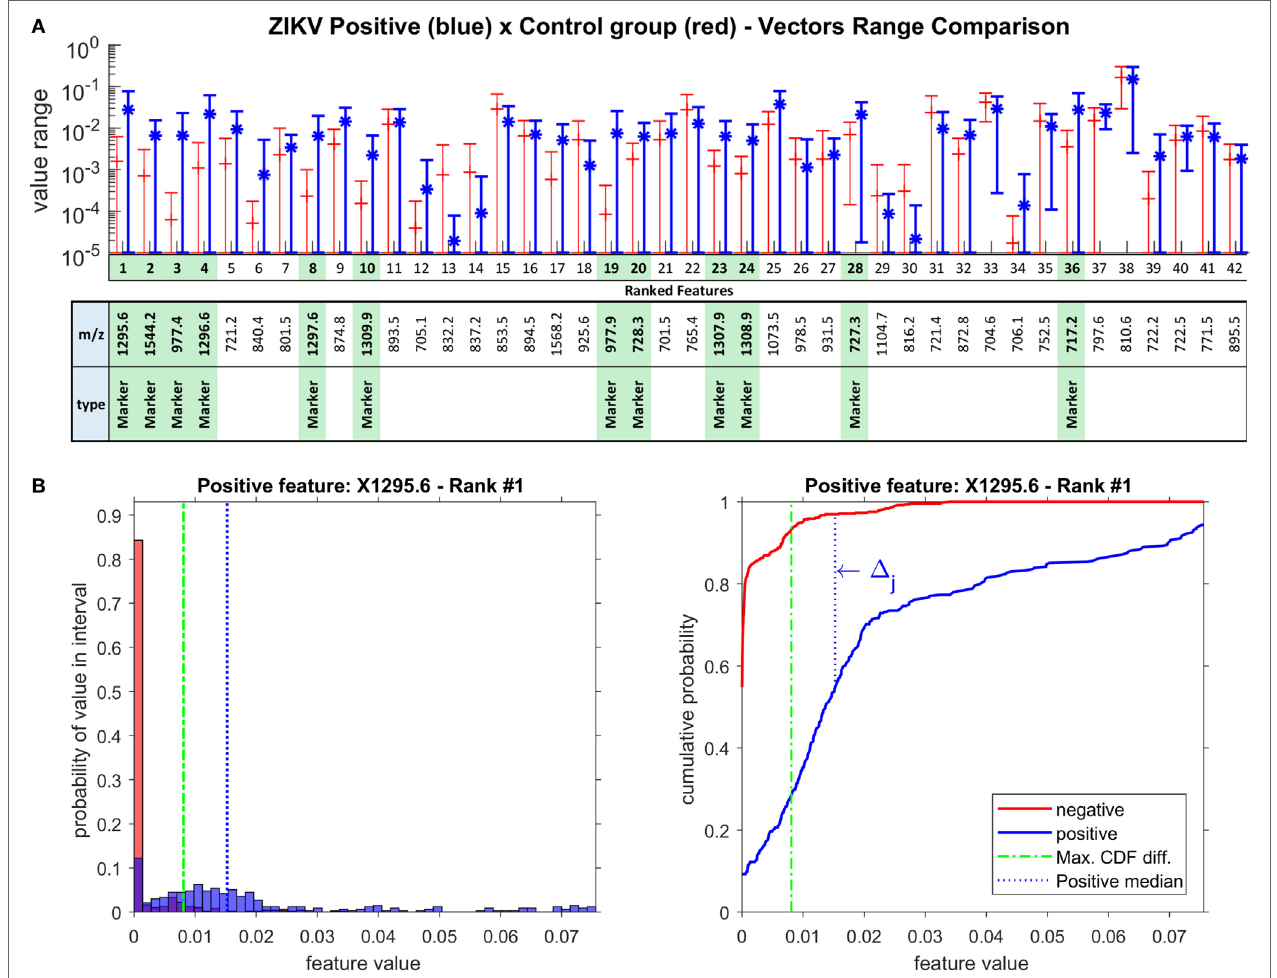
FigUre 3 | (a) Ranked features SD range in log scale for Zika virus (ZIKV) positive and control group (negative) vectors. The green highlight identifies the marker features for ZIKV, selected using the rationale of Δ j > 40%. (B) Example of probability distribution and cumulative distribution charts for the main ranked feature for ZIKV, ion m/z 1,295.6 (Ganglioside); the rationale for Δ j calculation is given on the right